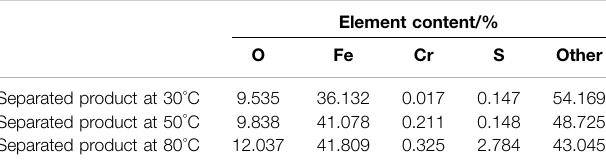
TABLE 4 | The elements in the separated products of the ferrochromium at different temperatures. Element content/% O Fe Cr S Other Separated product at 30 °